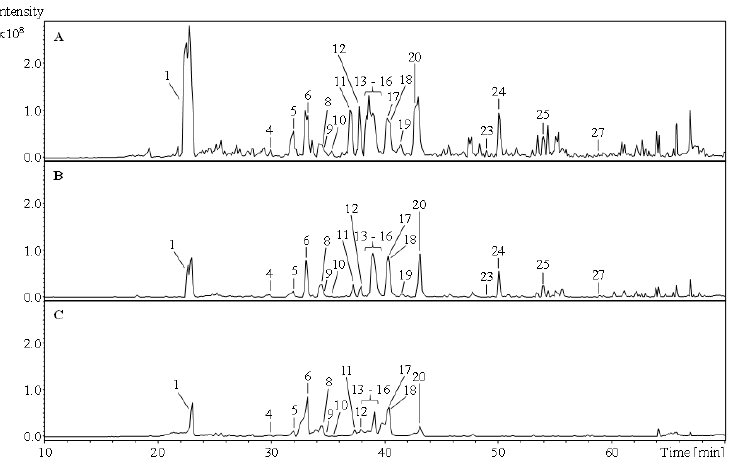
Figure 1. Comparison of total ion chromatograms (TIC) of the Achillea atrata acetone/water extract ( A ) and the corresponding ethyl acetate ( B ) and n -butanol ( C ) fractions. 1: chlorogenic acid; 4: quercetin- O -hexoside I; 5: 4-methyl-3-methoxy-9a-hydroxyligballinol- O -glucoside (formate adduct); 6: quercetin-3- O -rutinoside; 8: luteolin-hexoside; 9: quercetin- O -hexo-